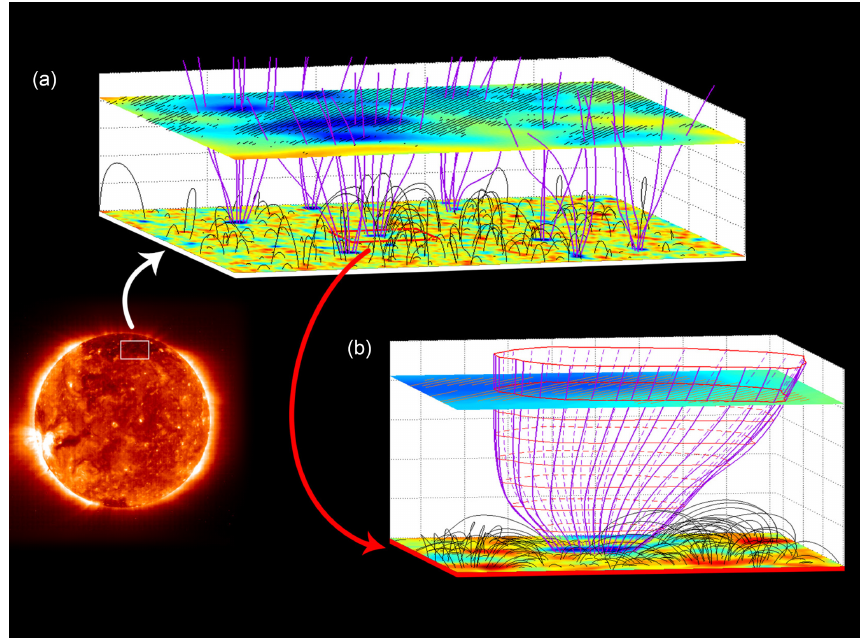
Figure 5. Illustration after Tu et al. (2005) of the solar magnetic transition region, showing the solar disk (left) together with a segment of the coronal magnetic field at the pole (a) and a further blow-up of part of that field (b) , which attains the shape of a rapidly expanding coronal funnel. The open magnetic field lines are drawn in magenta, and the field strength is indicated in blue on the top plane at a height of 20Mm, where the outflow speed of 10kms − 1 is indicated by hatched